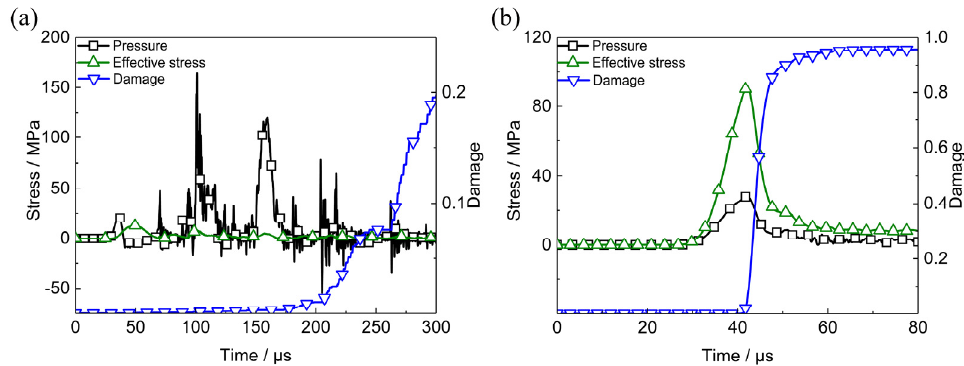
Figure 5. Dynamic mechanical responses of PBX1314 and PBX9501 under multi axial compression. ( a ) Pressure, effective stress and damage of PBX1314, ( b ) pressure, effective stress and damage of PBX9501.